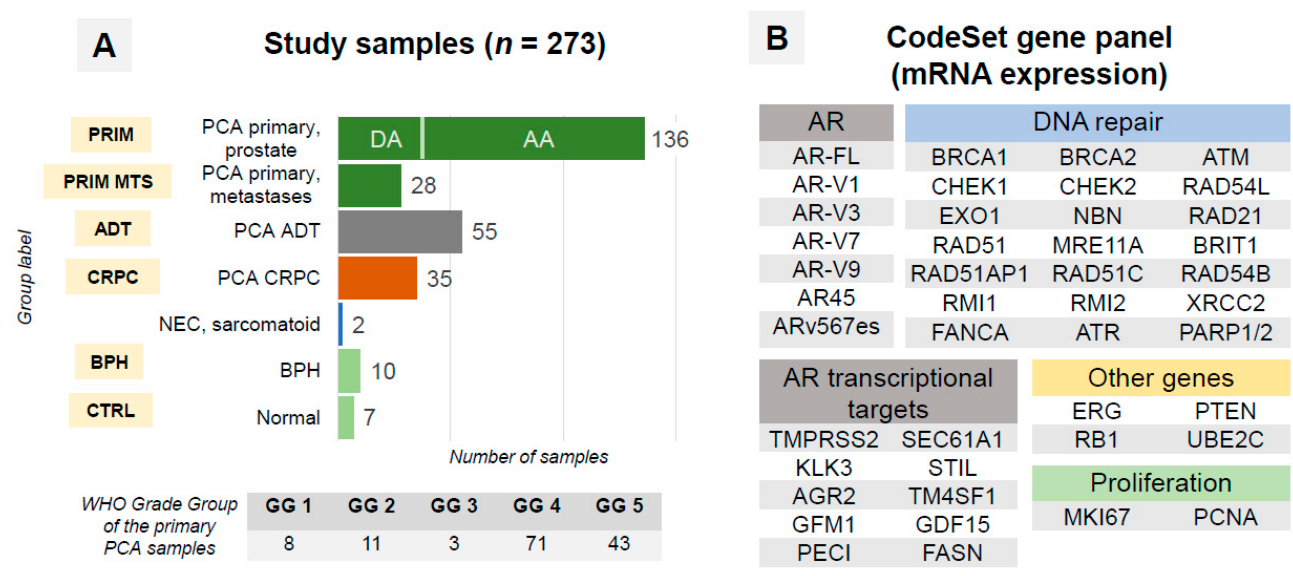
Figure 2. ( A ) Structure of the samples in study cohort and group labels used in further Figures. Among primary prostate cancer samples, 33 ductal adenocarcinoma (DA) samples were analyzed.